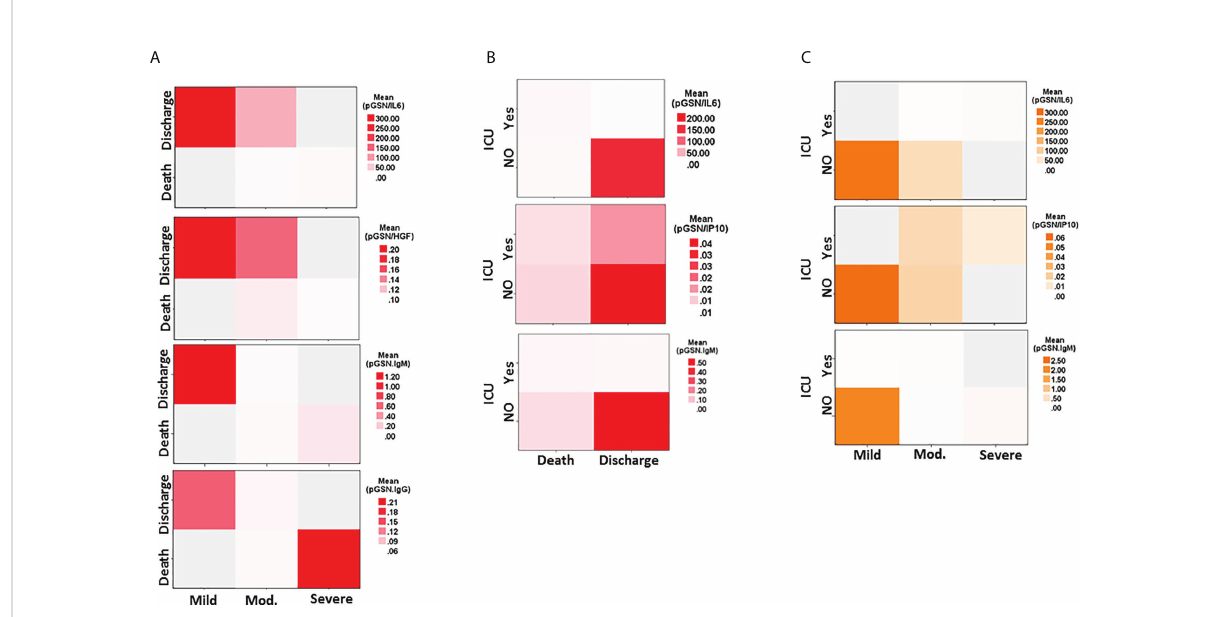
FIGURE 6 Multi-analyte panel of pGSN with cytokines and antibodies predict more than one clinical outcome of COVID-19. pGSN/IL-6, pGSN/HGF, pGSN/IP-10, pGSN/IgM and pGSN/IgG were used in a heat map analyses to predict (A) disease severity and hospitalization outcomes, (B) ICU admissions and hospitalization outcomes and (C) disease severity and ICU